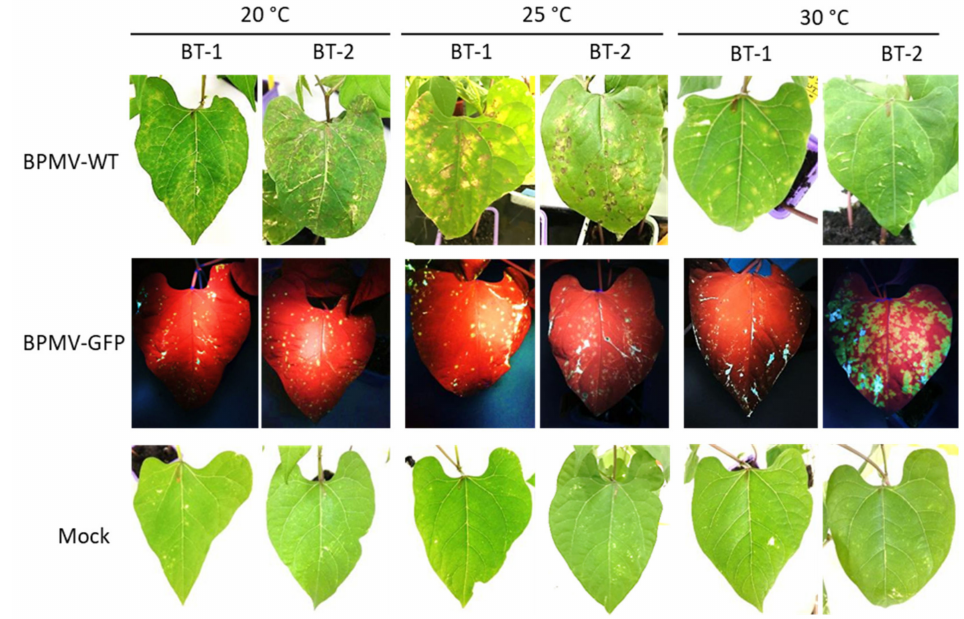
Figure 5. BT-1 and BT-2, two Near Isogenic Lines for the I locus are both resistant to BPMV systemic movement: Representative pictures of four BT-1- and four BT-2-inoculated leaves (sampled on four different plants) grown respectively at 20 ◦ C, 30 ◦ C and 35 ◦ C, 7 days post-inoculation (dpi) with BPMV-WT (upper panel), BPMV-GFP (middle panel), and Mock (lower panel). BPMV-GFP was detected under UV light. This experiment was performed twice with similar